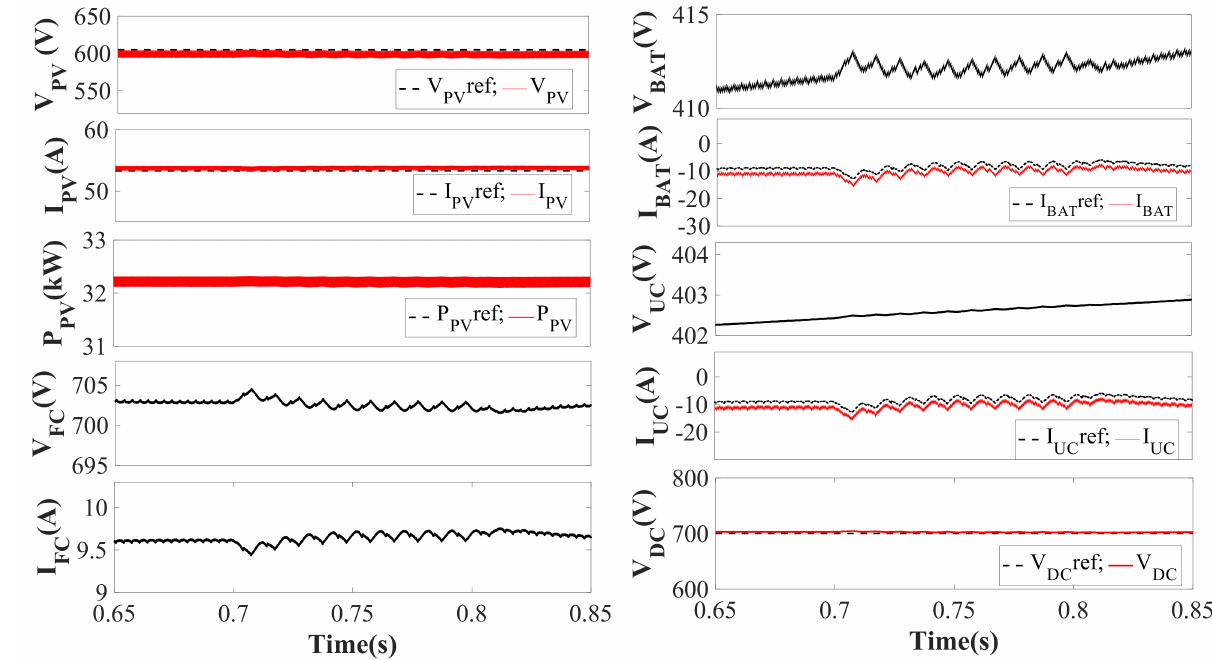
Figure 9. Dynamic performance during load unbalancing V PV , I PV , P PV ,V FC , I FC ,V Bat , I Bat , V UC , I UC , and V DC